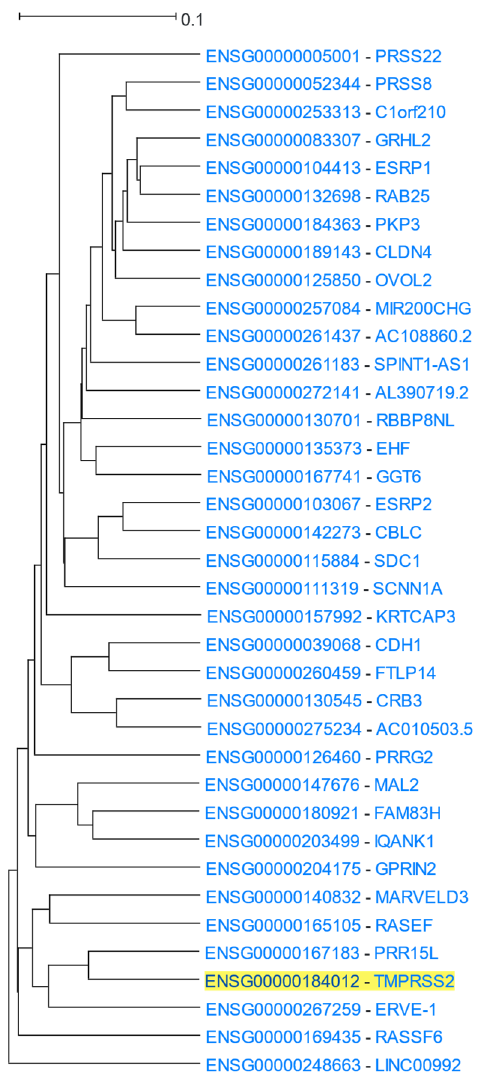
Figure 7. HGCA2.0 TMPRSS2 6 internal node coexpression clade.